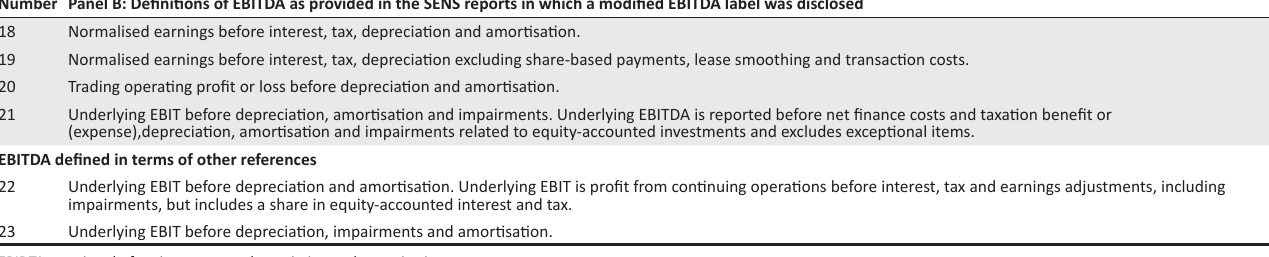
How companies labelled EBITDA in their performance discussions in the SENS reports